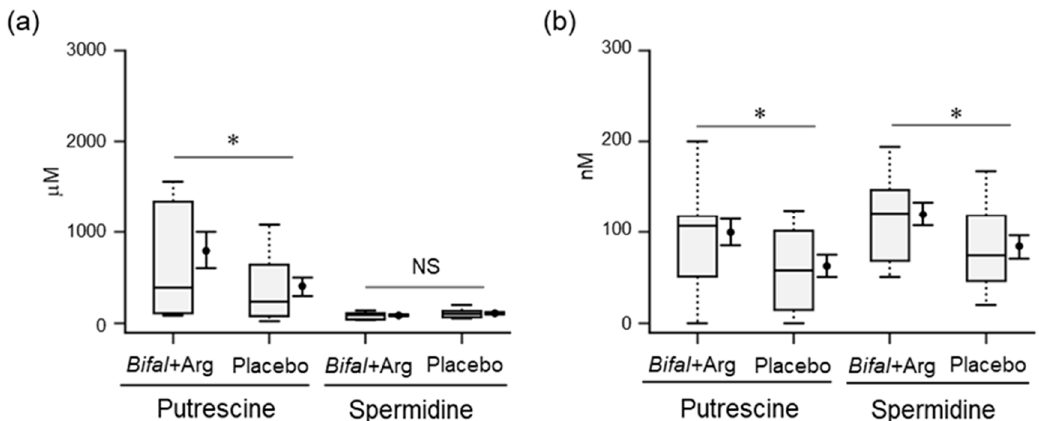
Figure 4. Effect of the consumption of yogurt containing B. animalis subsp. lactis and Arg (Bifal + Arg YG) on the concentration of fecal and serum polyamines. Boxplots represent the 5th percentile, 95th percentile, interquartile range (25–75%), and median. The black circle and error bars on the side of the boxplots represent the average value and SEM, respectively. ( a ) Fecal putrescine and spermidine concentrations at week 12. * p < 0.05, Mann–Whitney U test. n = 17 in the Bifal + Arg YG group and n = 16 in the placebo group. One subject in the Bifal + Arg YG group did not submit feces; therefore, it was regarded as a missing value. ( b ) Serum putrescine and spermidine concentrations at week 12. * p < 0.05, Student’s t -test. In the case of serum putrescine, n = 17 in the Bifal + Arg YG group and Figure S3). In the case of serum spermidine, n = 17 in the Bifal + Arg YG group and n = 16 in